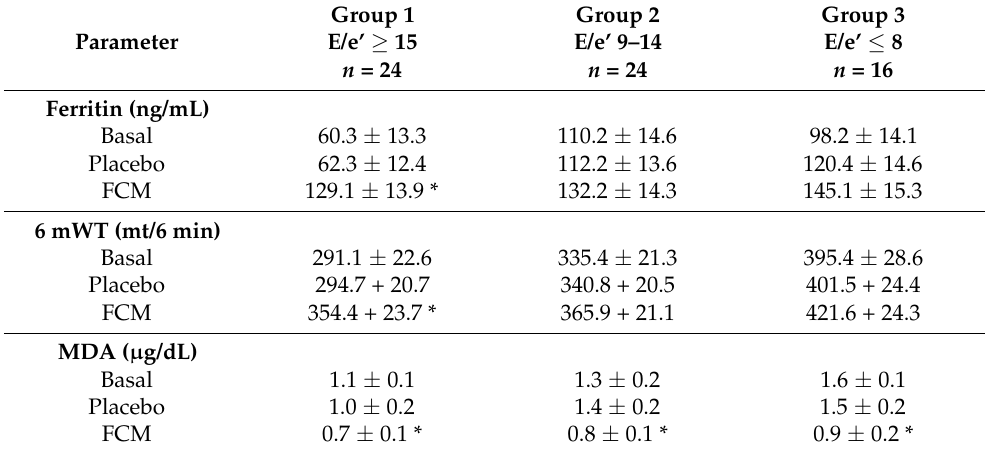
Table 3. The effect of placebo or FCM on ferritin, TSAT, 6MWT, and MDA levels in patients with HFpEF according to their diastolic function as expressed by E/e’ ratio. Data are expressed as mean ± S.E.M. Group 1 Parameter